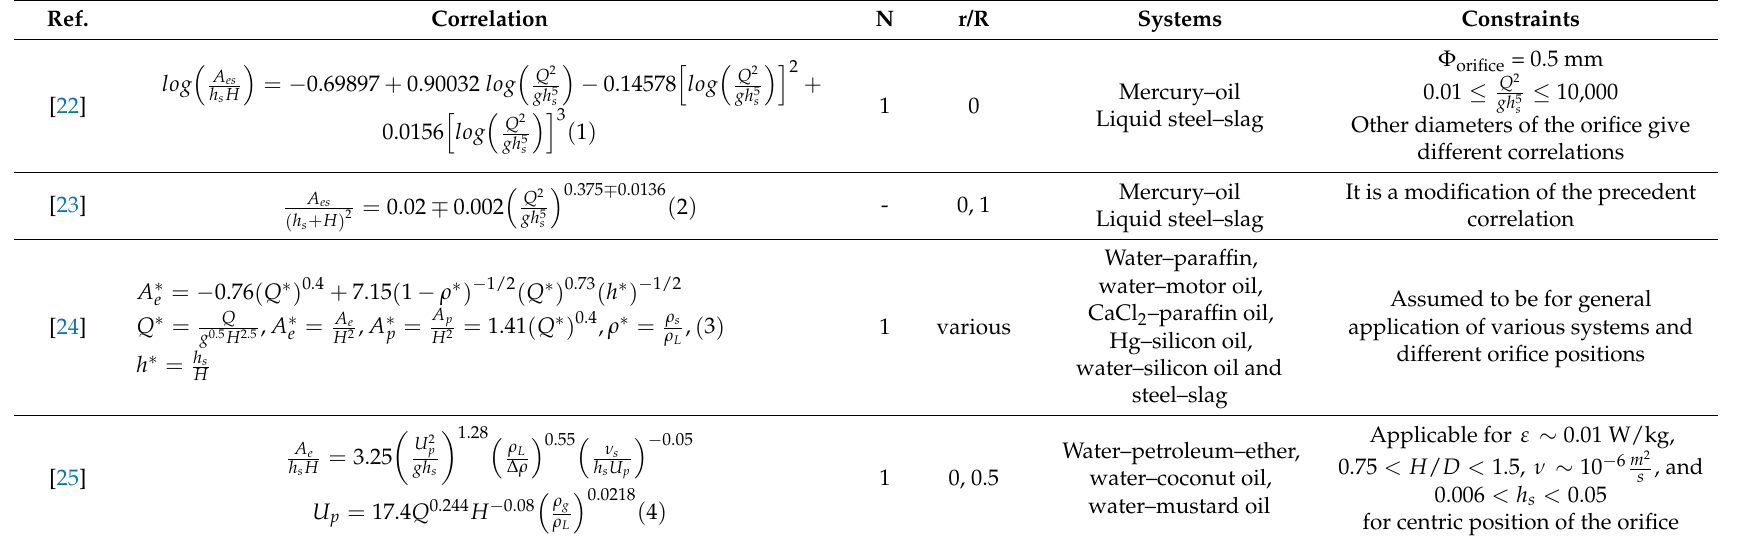
Table 3. Correlations to estimate the size of the open steel eye during stirring operations in